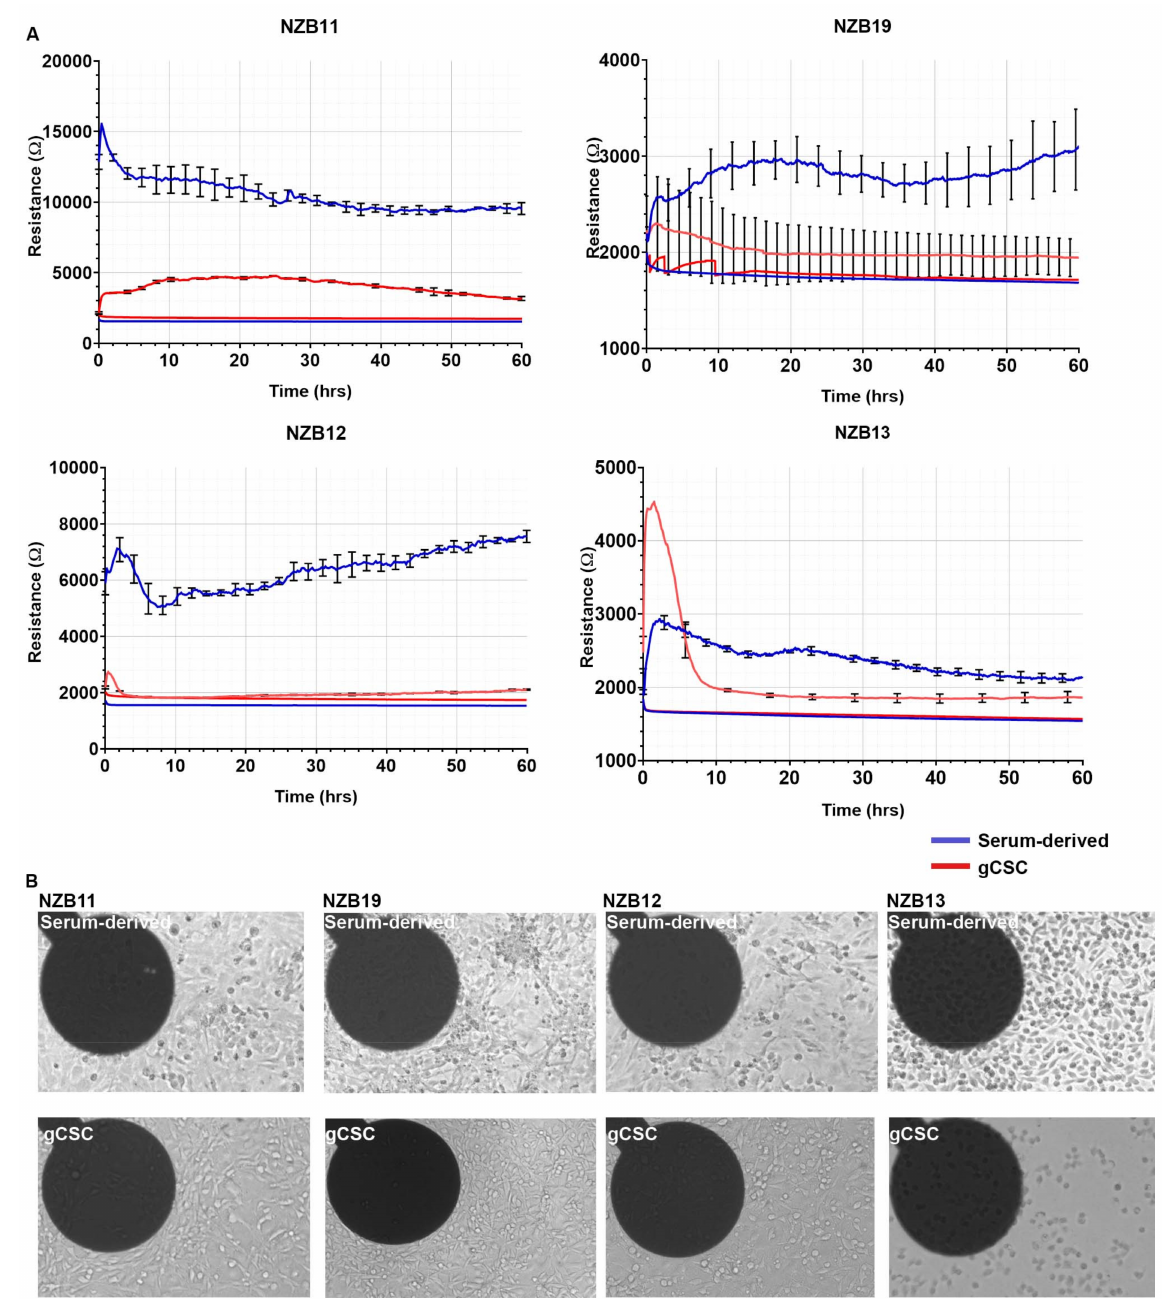
Figure 4. Serum-derived and gCSC cell resistance on 96W1E+ ECIS arrays. ( A ) Resistance measurements at 4000 Hz over 60 h of growth. Comparison of adhesion profiles of NZB11, NZB12, NZB19, and NZB13 serum-derived and gCSC cells seeded at 80,000 cells per well. Adhesion profiles referenced against a cell-free well control (bottom flat red and blue lines) are shown. Data are representative of three independent replicates. ( B ) Phase contrast images of NZB11, NZB12, NZB19, and NZB13 serum-derived and gCSC cells after 60 h of growth on 96W1E+ ECIS arrays. Dark circles are recording electrode regions. Images acquired at 20 × magnification. Data is representative of three independent replicates. See Supplementary Figure S1 for a contrast-adjusted zoom of the electrodes, which reveals adherent cells on